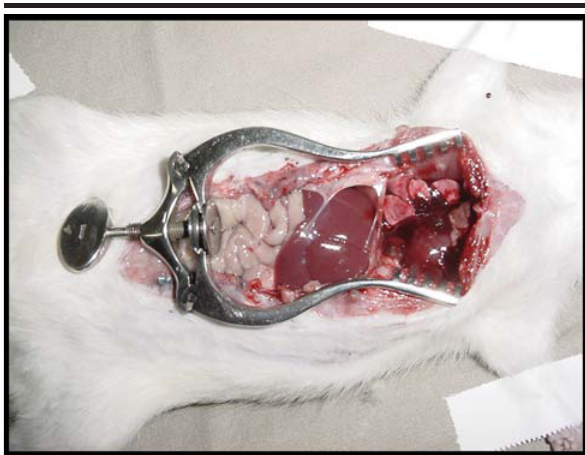
FIGURE 7 - A - Picture of removed liver. B - Picture of FIGURE 4 - Picture of an animal in the experimental group after relaparotomy (Thoraco-phreno-laparotomy).